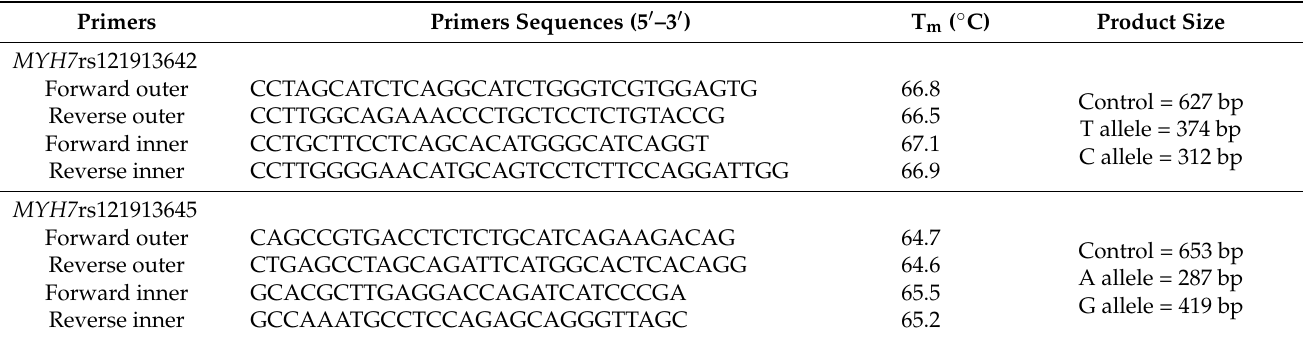
Table 1. Tetra ARMS-PCR primer sequence details for genotyping of